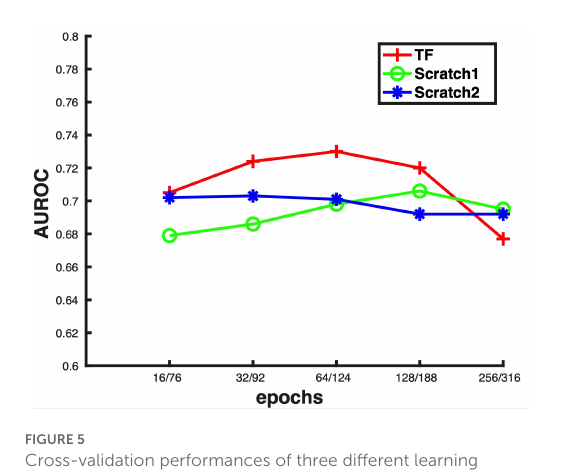
FIGURE5 Cross-validation performances of three different learning strategies by using different epochs for the second-stage model. TF: Transfer learning; Scratch1: Learning from scratch with epochs from 16 to 256; Scratch2: Learning from scratch with epochs from 76 to 316.